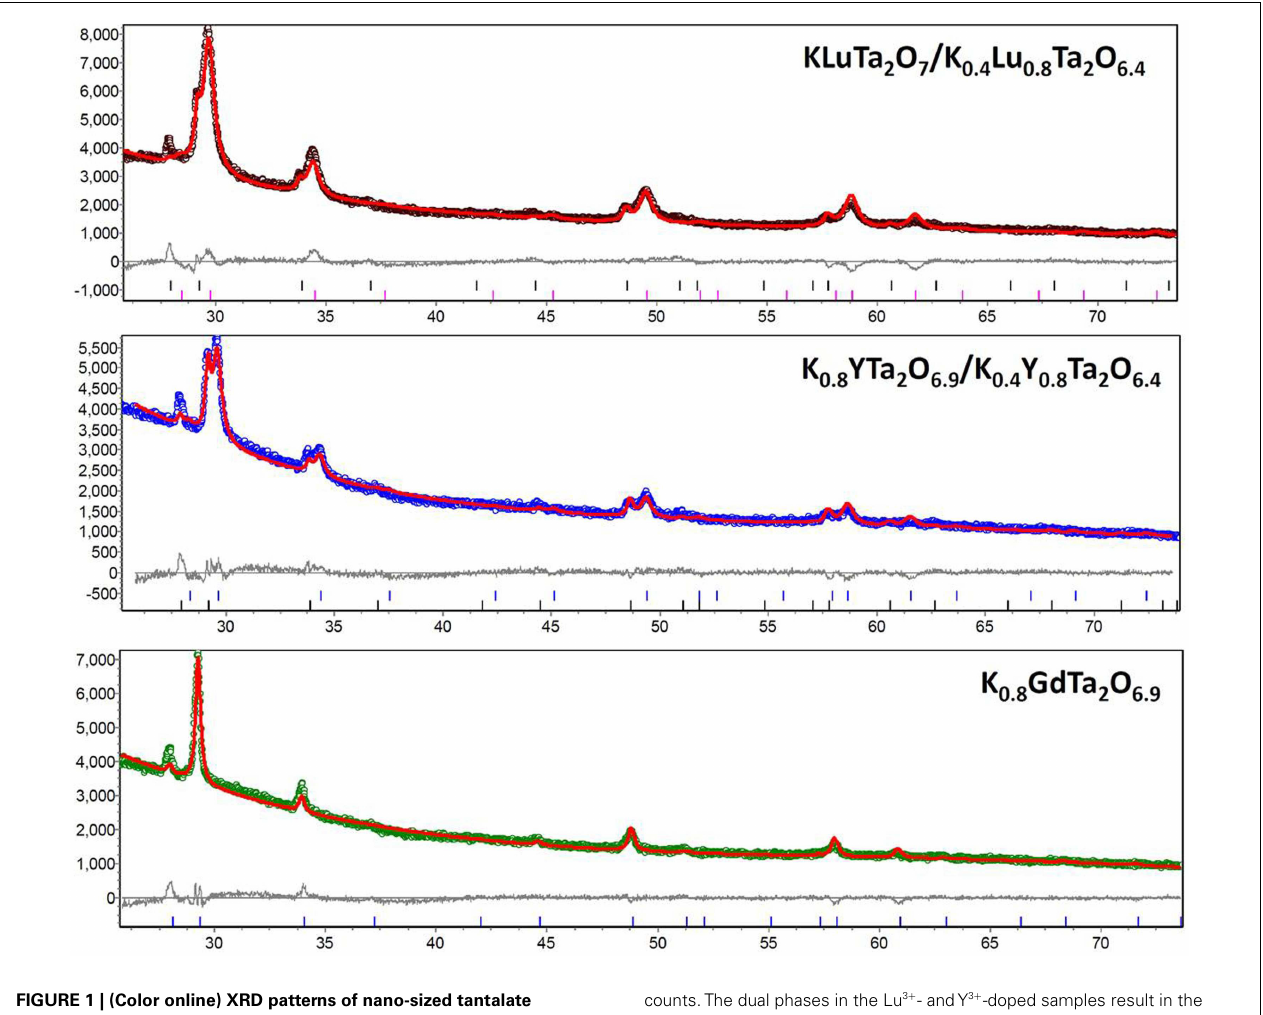
FIGURE 1 | (Color online) XRD patterns of nano-sized tantalate pyrochlore samples and the corresponding Rietveld refinement fittings .The x -axes are 2-Theta position and the y -axes are intensity in